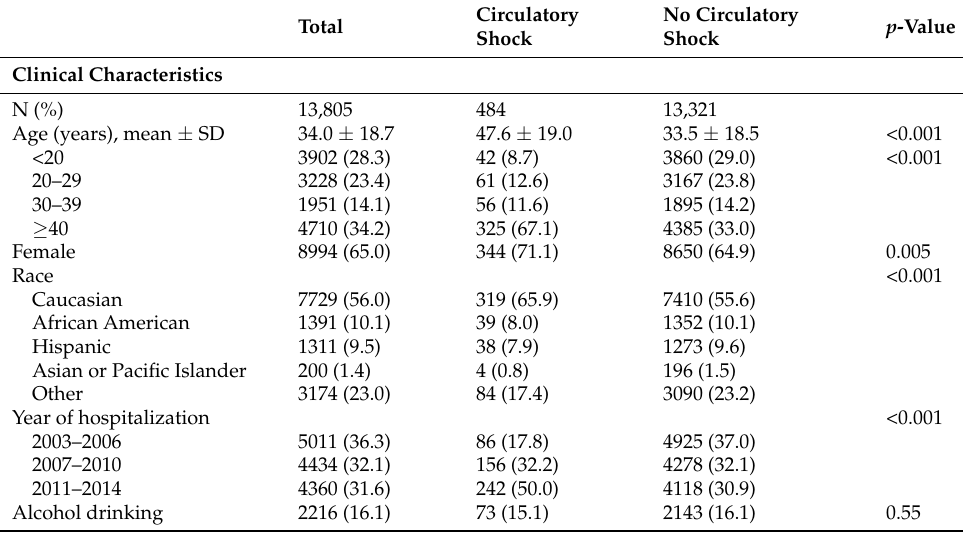
Table 1. Clinical characteristics, in-hospital treatments, outcomes, and resource utilization in salicy- late intoxication patients with and without circulatory